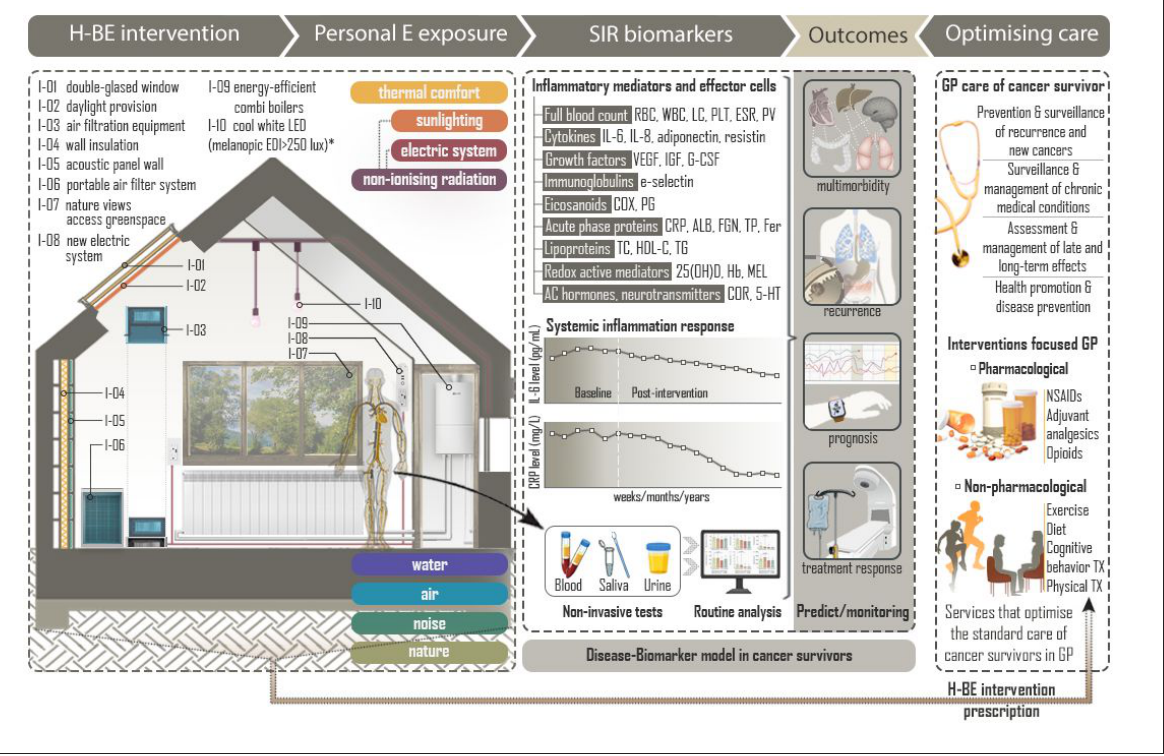
Figure 1 Conceptual framework describing the relationships between home- built environment intervention, systemic inflammatory response, clinical outcomes and general practice care of survivors of cancer. 5- HT = 5- hydroxytryptamine/serotonin. AC = adrenal cortex. ALB = albumin. COR = cortisol. COX = cyclooxygenase. CRP = c- reactive protein.